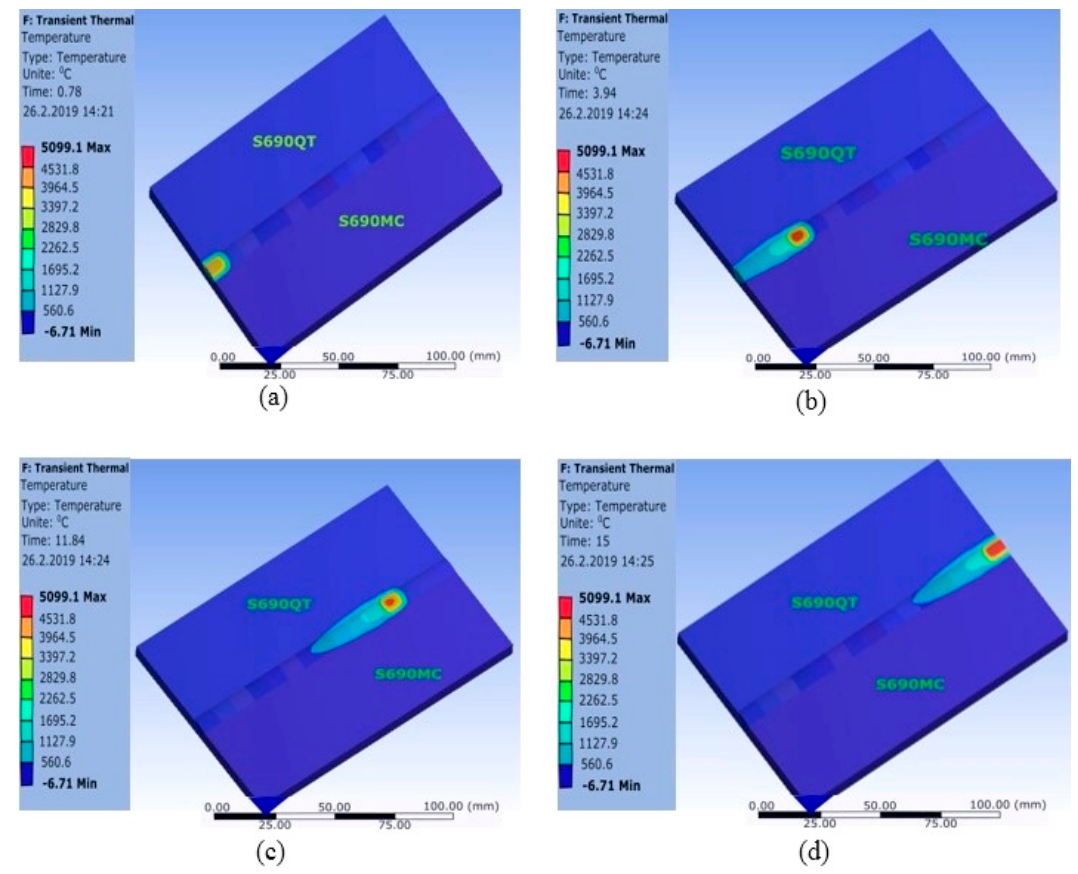
Figure 5. Thermal simulation process: ( a ) starting process; ( b ) simulation after 15 s; ( c ) simulation after 45 s; ( d ) the end of the process after 60 s.